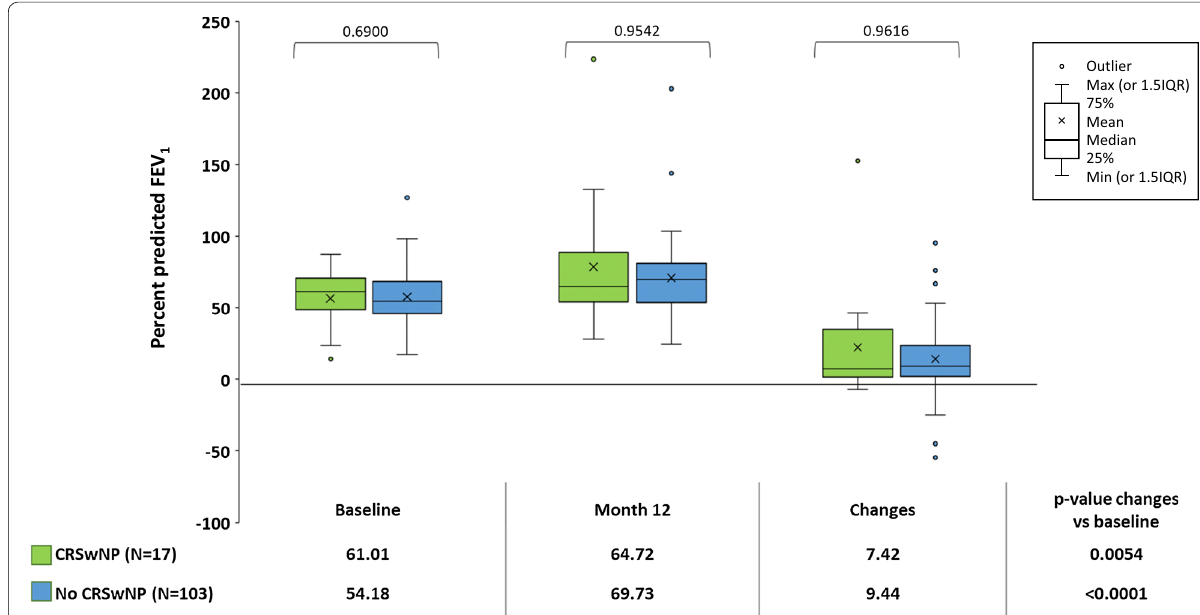
Fig. 2 Lung function assessed via percent predicted forced expiratory volume in 1 s (FEV 1 ) at baseline and 12 months’ after omalizumab treatment, and change from baseline in percent predicted FEV 1 , in patients with severe allergic asthma, with chronic rhinosinusitis with nasal polyps (CRSwNP) or without CRSwNP (No CRSwNP). The p-values within cohorts were calculated using a signed rank test and p-values for comparisons between cohorts were calculated using an ANCOVA model on ranks